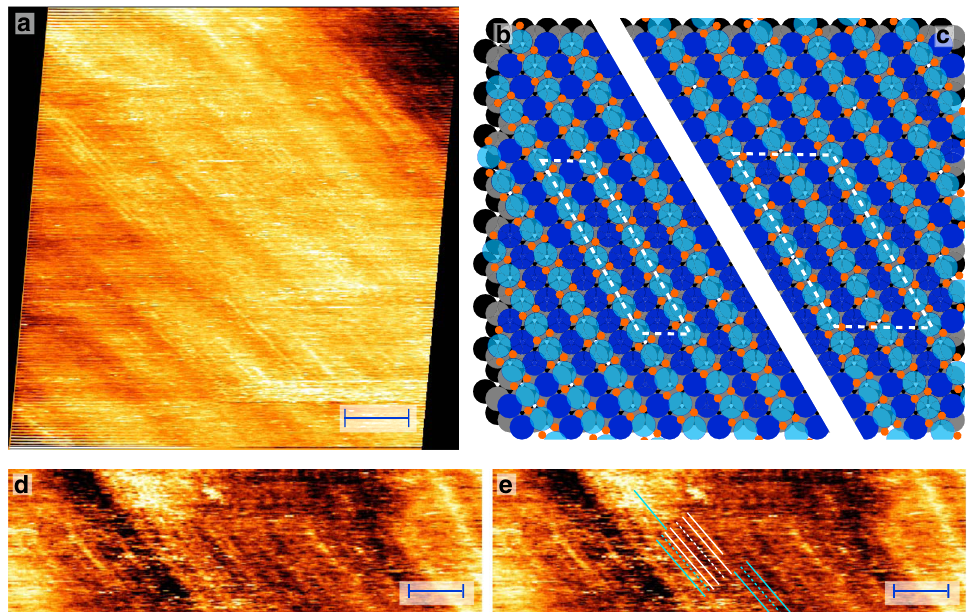
Fig. 3 Structures at higher O 2 pressure. Lifted-row structure formed at higher O 2 pressure (observed above 2.2 bar). STM image ( a ) recorded at 535 K in 3.8 bar O 2 , and 98 min in the experiment, while increasing the total pressure from 2.7 to 6.0 bar. The image is shown after drift correction and some nonlinear fi ltering to remove a few horizontal scan vibrations; Ball model of two examples of the lifted-row oxide in which the O atoms are ordered differently: lifted rows are in phase ( b ) resulting in straight lines of O atoms and the smallest O – O separation; largest O – O separation ( c ), due to shifting of adjacent rows by half a period. These structures have a (2 × 8) and c (4 × 8) unit cell, b and c respectively; Two replicas of an enlarged detail ( d , e ) of the lifted-row structure. Indicated lines ( e ) show several interesting features: missing rows, a light domain wall, and point defects. (Shown without drift correction but with a modest amount of nonlinear fi ltering to remove a few horizontal scan vibrations.) Scale bars represent 4 nm ( a ) and 3 nm ( d , e